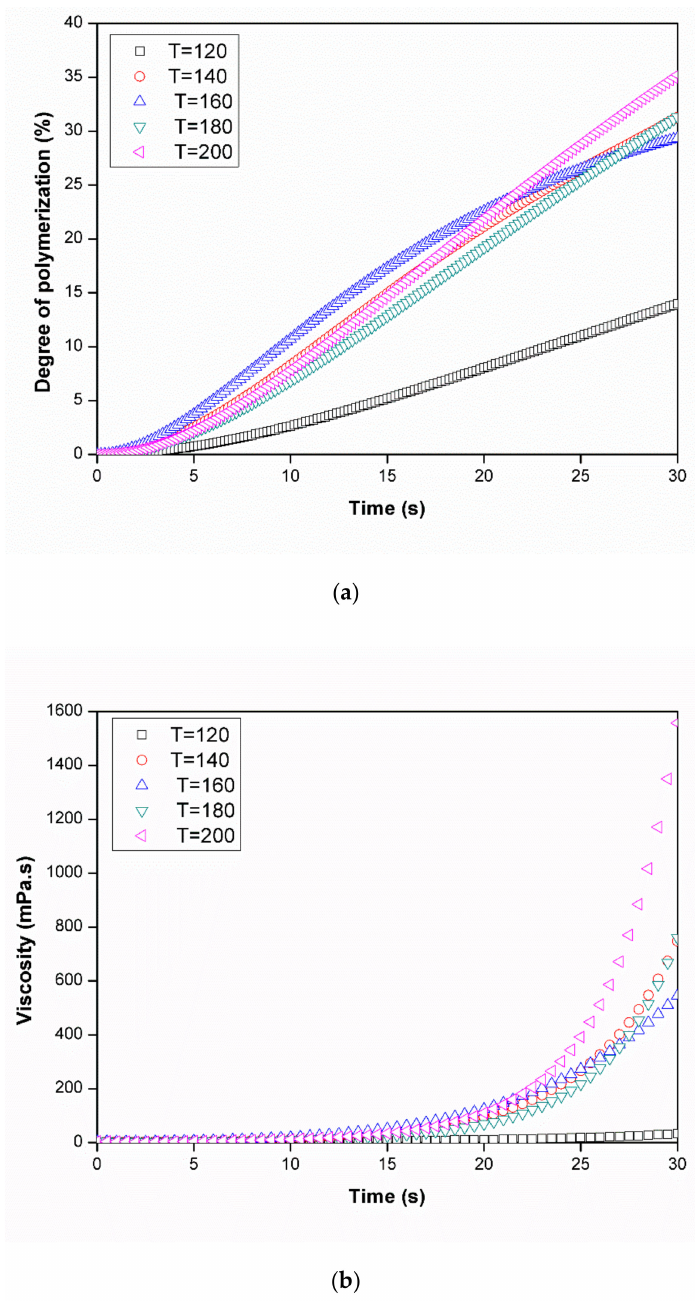
Figure 16. Degree of polymerization profile ( a ) and viscosity profile ( b ) of ε -caprolactam during the first 30 s at di ff erent